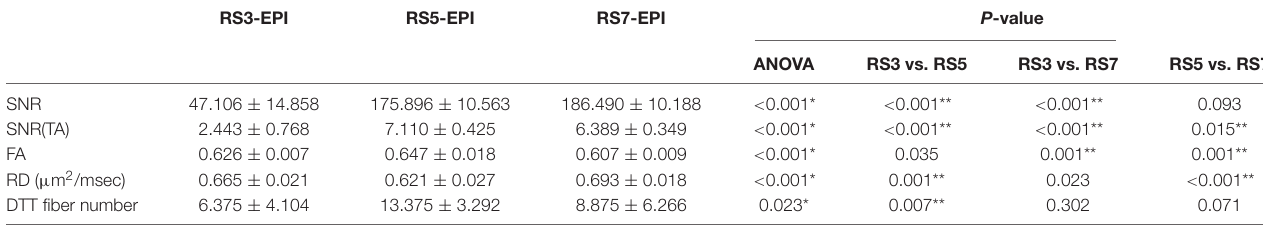
TABLE 1 | SNR and quantitative DTI analysis.